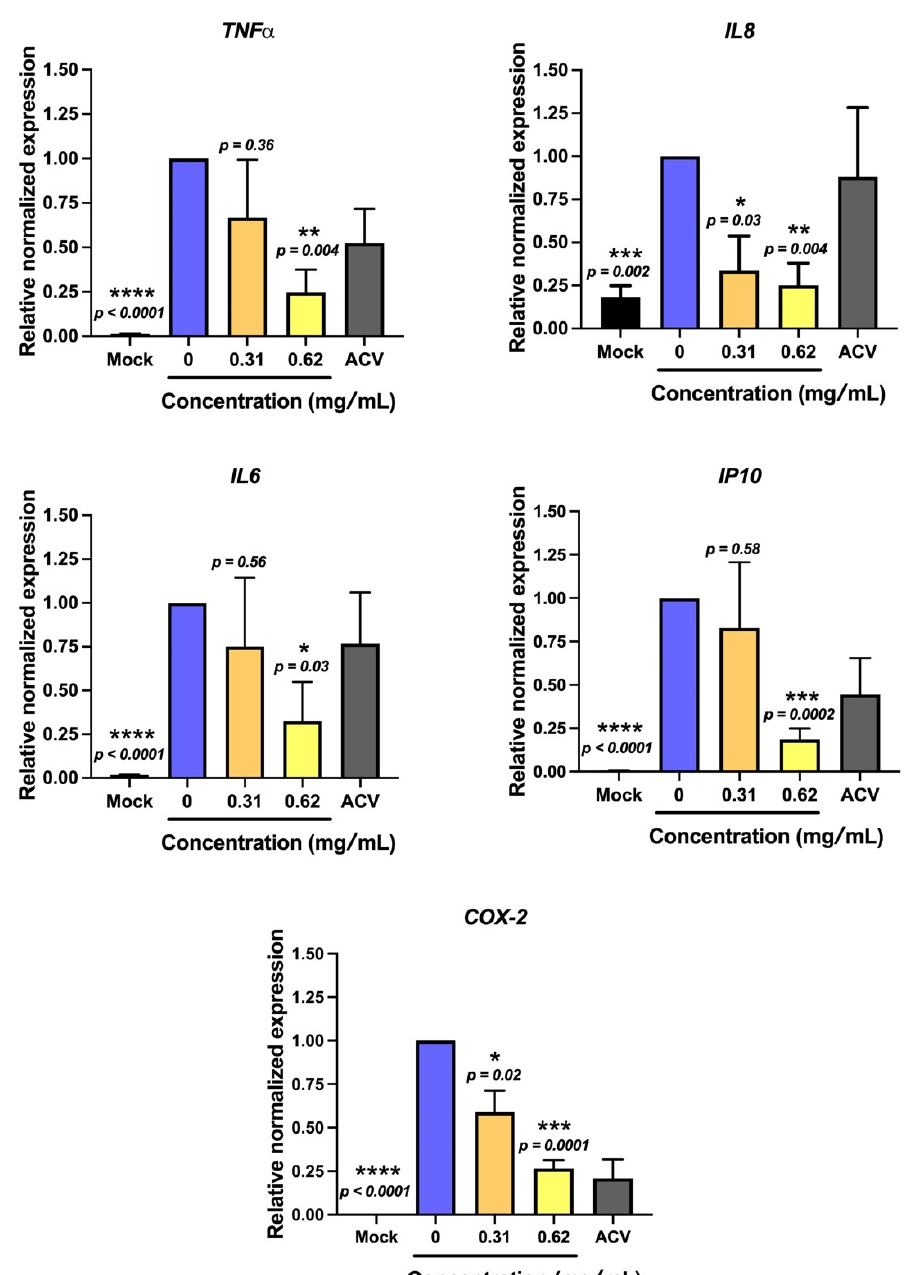
Figure 5. Effect of non-sericin extract on lowering inflammatory gene expression in HSV-2 infected cells. HeLa was infected with HSV-2 in the absence or presence of non-sericin extract at the concen- trations of 0.31 and 0.62 mg/mL and measured for the gene expression level of TNF α , IL6 , IL8 , IP10 and COX-2 by real-time PCR after 48 h after infection. The normalized gene expression of TNF α , IL6, IL8, IP10 and COX-2 were represented relative to non-treatment control (set as 1). The statistical differences were analyzed comparing to the expression of the non-treatment control (* indicates p < 0.05, ** indicates p < 0.005, *** indicates p < 0.0005 **** indicates p < 0.0001).